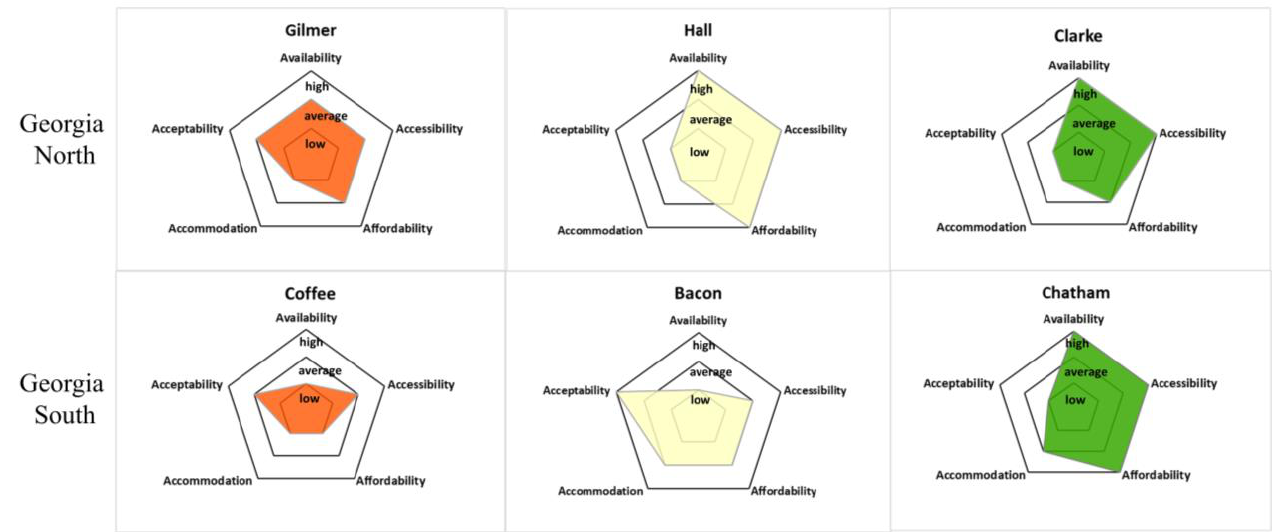
Figure 5. The 5 As distribution example counties in Georgia North (Gilmer, Hall, and Clarke) and South (Coffee, Bacon, and Chatham).